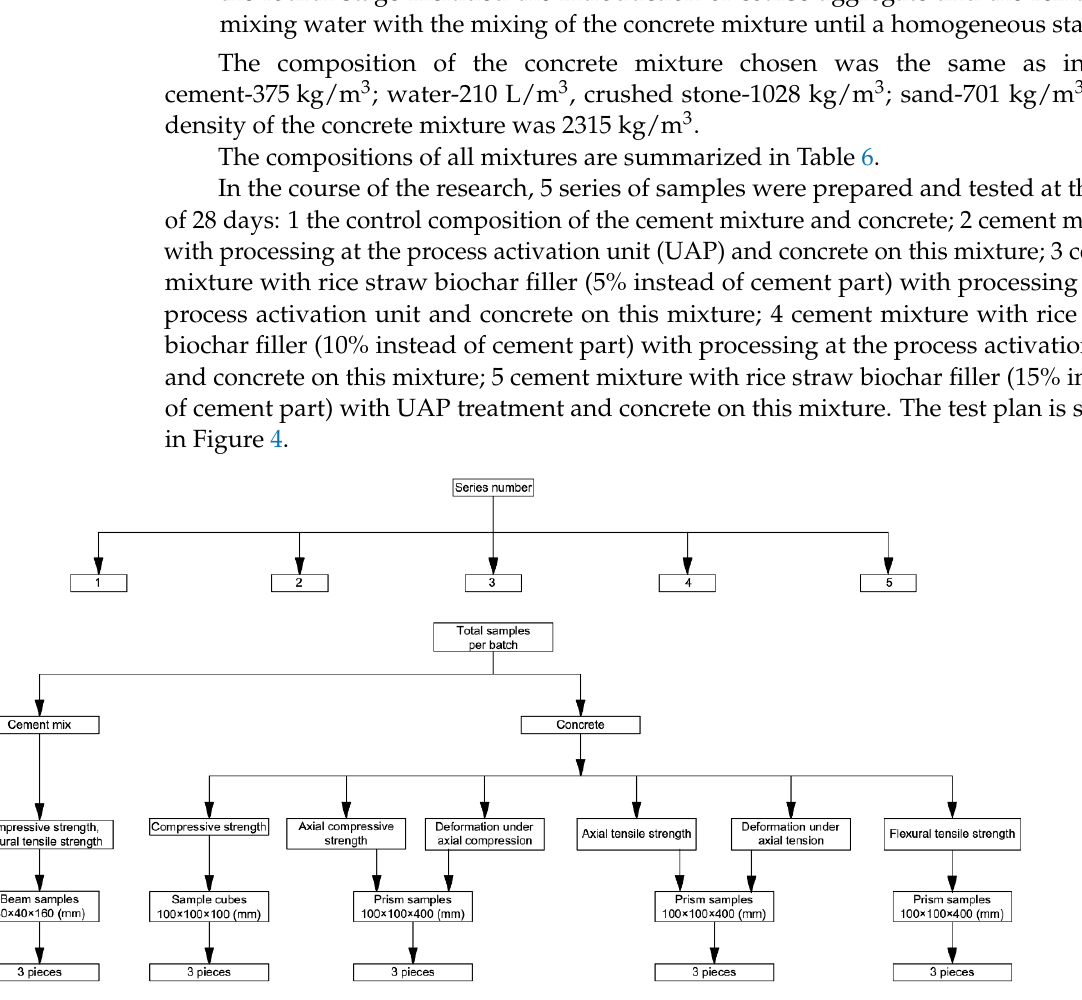
Figure 4. Experimental research